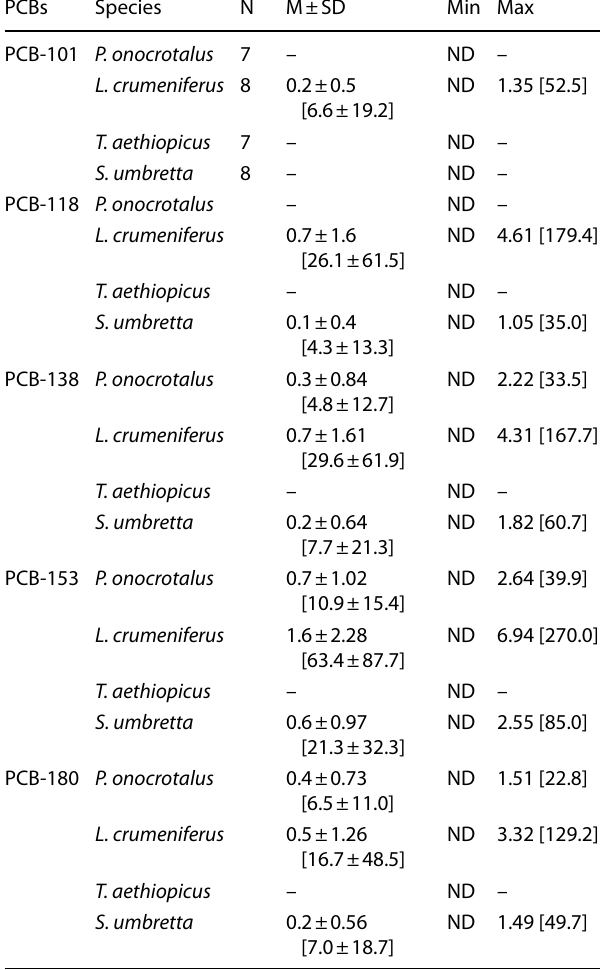
Table 3 Mean levels of PCB congeners (ng g-1 ww [ng g-1 lw]) with minimum and maximum values